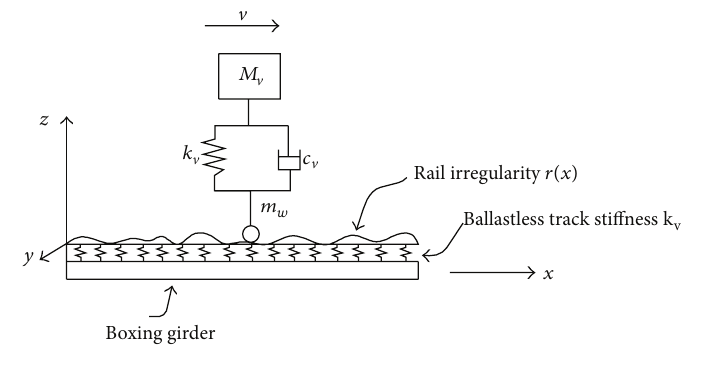
Figure 5: Vehicle-track-bridge element. Table 1: Calculation parameters of ICE3.